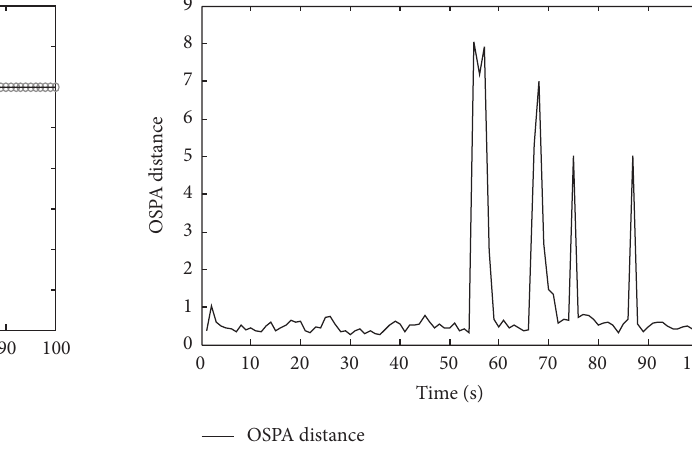
Figure 9: Number estimates. Figure 10: OSPA